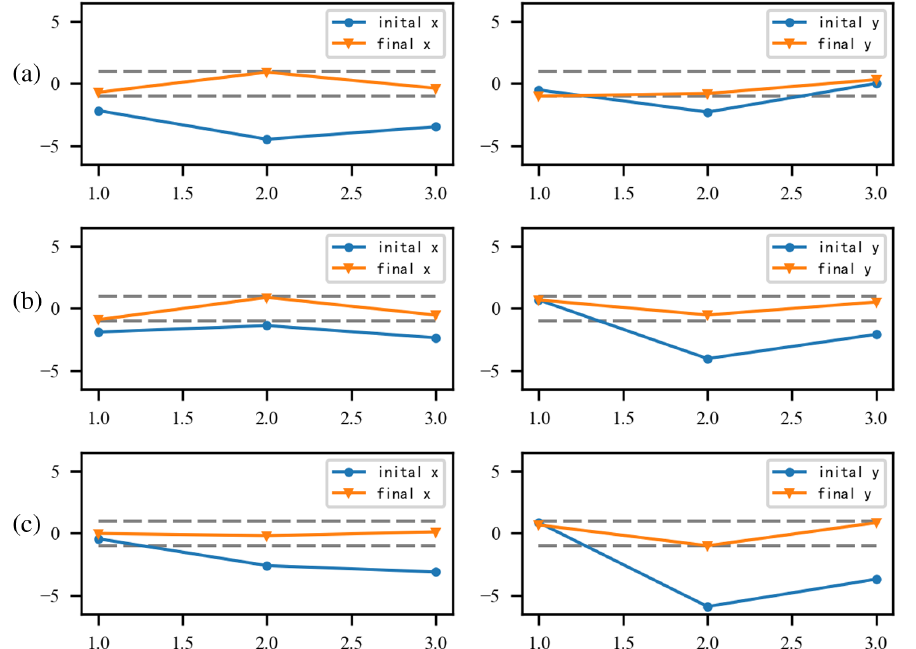
FIG. 7. The results of the agent on different beam lines. (a) Trained with 40 Ca 13 þ in a simulation environment and applied to 40 Ca 13 þ on CAFe II. (b) Trained with 55 Mn 18 þ in a simulation environment and applied to 40 Ca 13 þ on CAFe II. (c) Trained with 55 Mn 18 þ in a simulation environment and applied to a proton on CAFe II. The gray dotted line represents that the BPM reading is equal to 1 or − 1